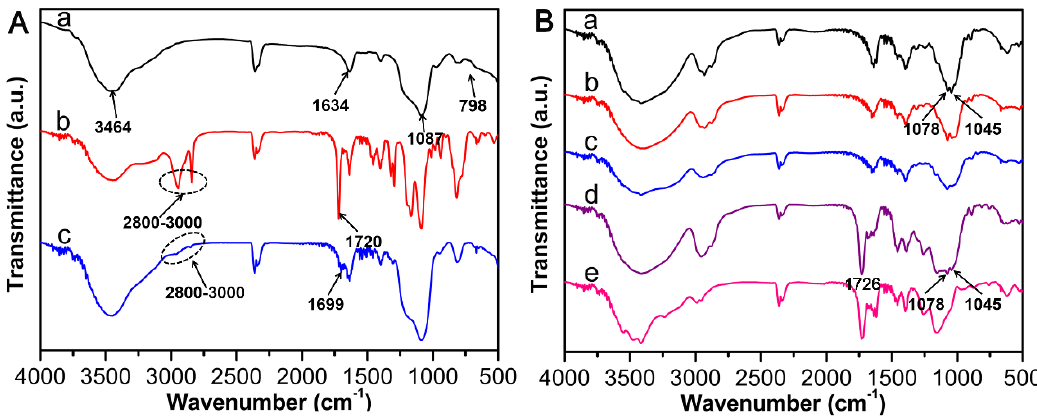
Figure 3. ( A ) FT-IR spectra of (a) SBA-15, (b) MPS and (c) SBA-15-MPS; ( B ) FT-IR spectra’s of (a) R 1